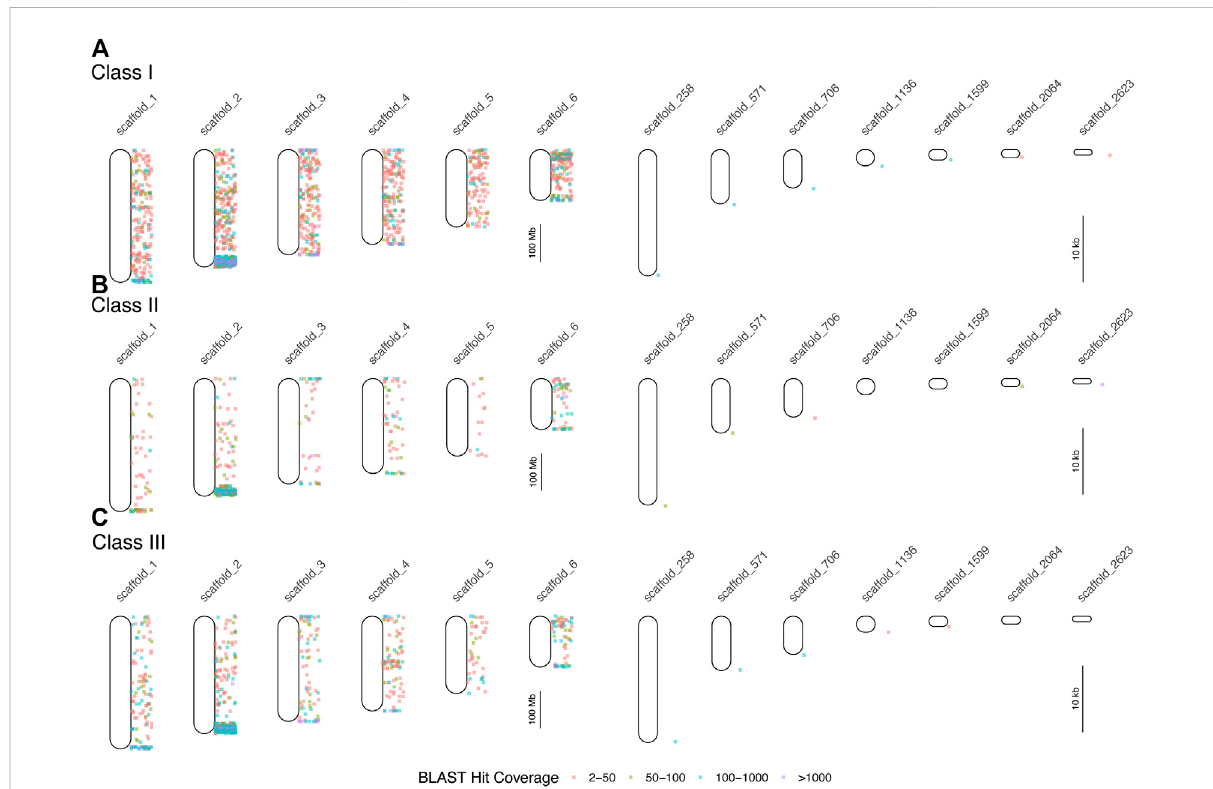
FIGURE 3 Results ofBLASTsearchesofhumanandmouseMHC proteindatainthebrownanole genome.Eachpoint indicatesthelocations ofBLASThits (binned by hit coverage; right of chromosome maps). Results are displayed separately for class I (A) , class II (B) , and class III (C) genes for all six scaffolds, which correspond to the six macrochromosomes, and for unplaced scaffolds with at least 100 hits and average hits per 100 bp of greater than 4. Note differences in scale between panels the panels devoted to chromosomes (left column) and unplaced scaffolds (right